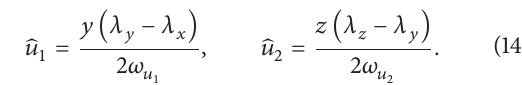
Figure 3: Numerical simulations of overweight (a) and obese (b) compartments and control variable (c) with different conditions of 𝜔 𝑢 𝜔 𝑢 2